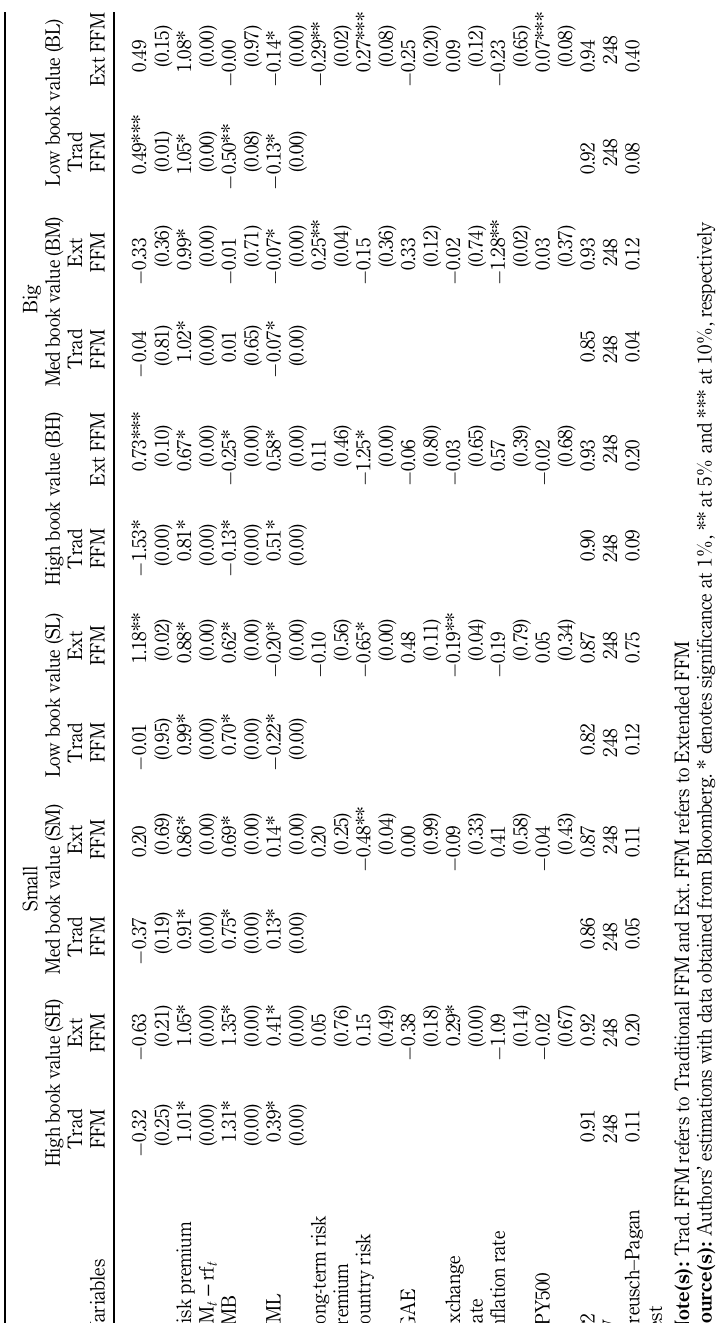
Table 4. Results portfolio